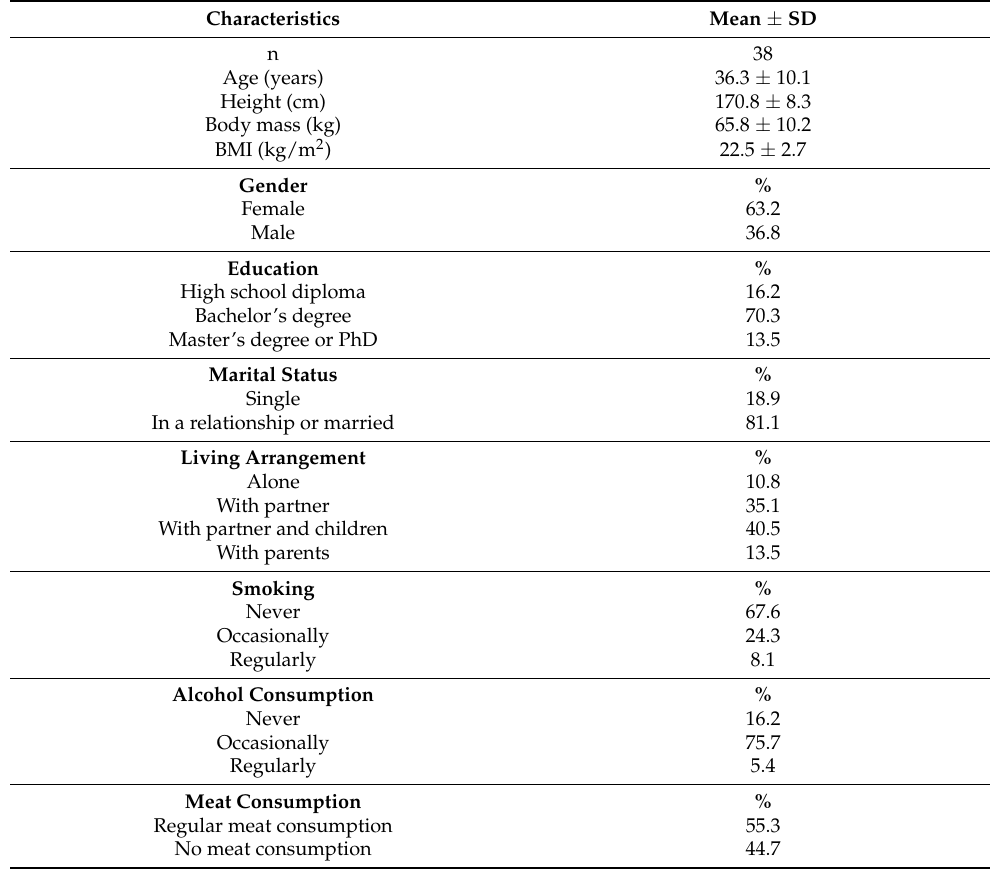
Table 1. Study Subjects’ Baseline Characteristics.